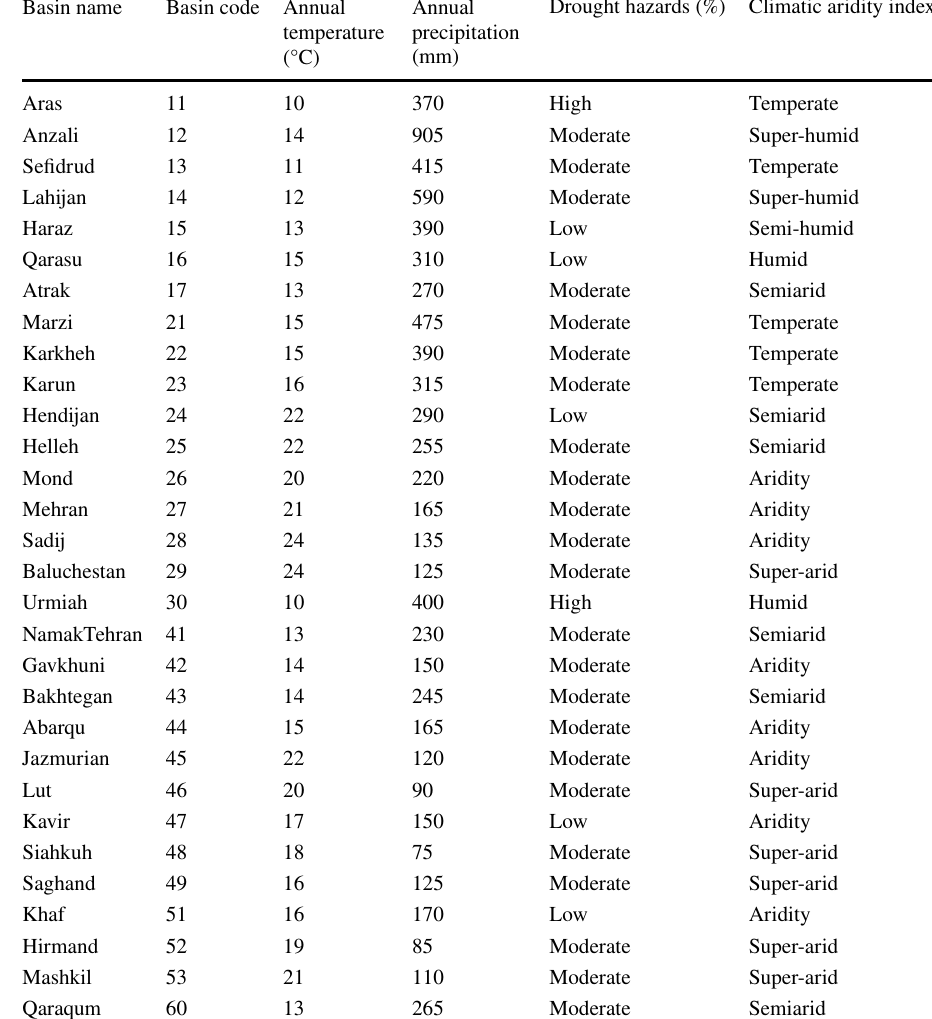
Table 5 Inventory of environmental variables of 30 major hydrological basins in Iran, including mean annual temperature, mean annual precipitation, drought hazards, and climatic